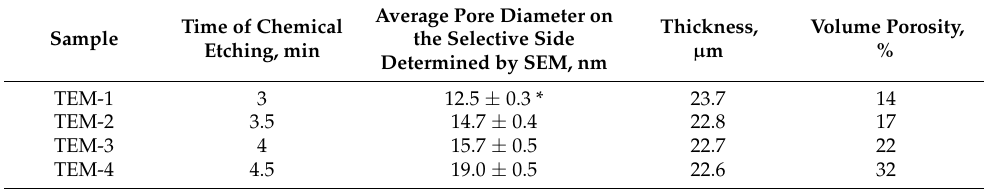
Table 2. Structural characteristics of track-etched membranes.